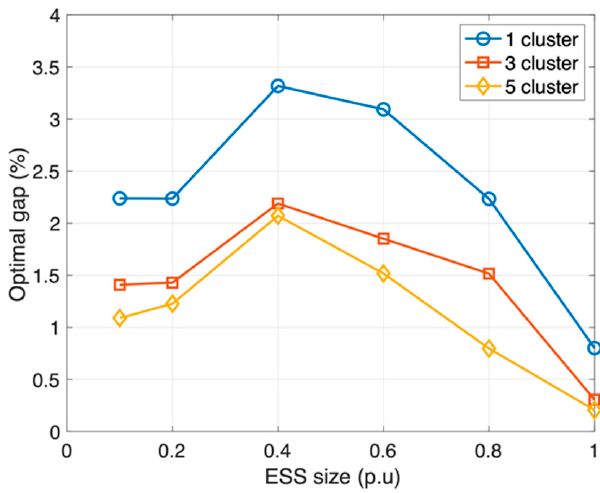
Figure 5. Change in optimal gap of the proposed method with 1, 3, and 5-cluster cases.